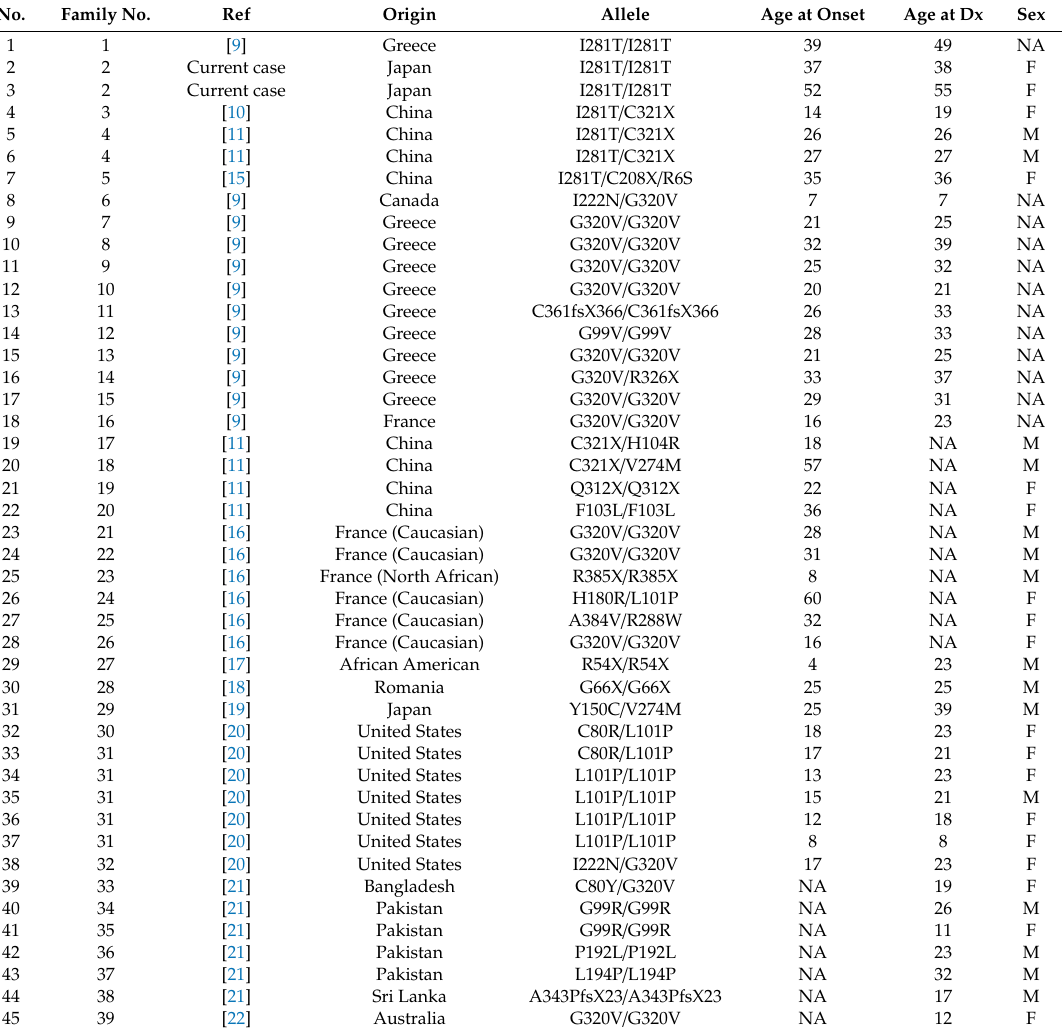
Table 2. Characteristics of patients with homozygous HJV mutations based on a review of the literature. Please note that cases with compound heterozygous mutations of the HJV gene with the non- HJV gene were excluded from this